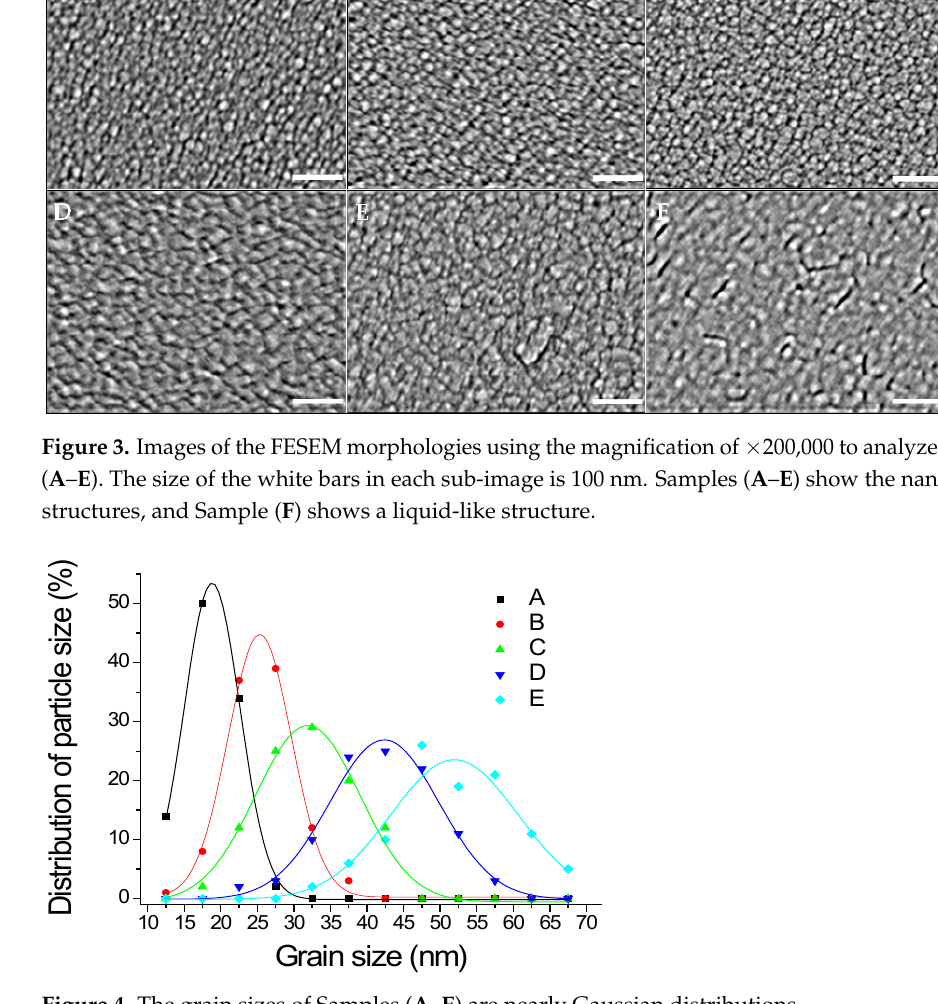
Figure 3. Images of the FESEM morphologies using the magnification of ×200,000 to analyze Sam- ples ( A – E ). The size of the white bars in each sub-image is 100 nm. Samples ( A – E ) show the nano- particle structures, and Sample ( F ) shows a liquid-like structure.